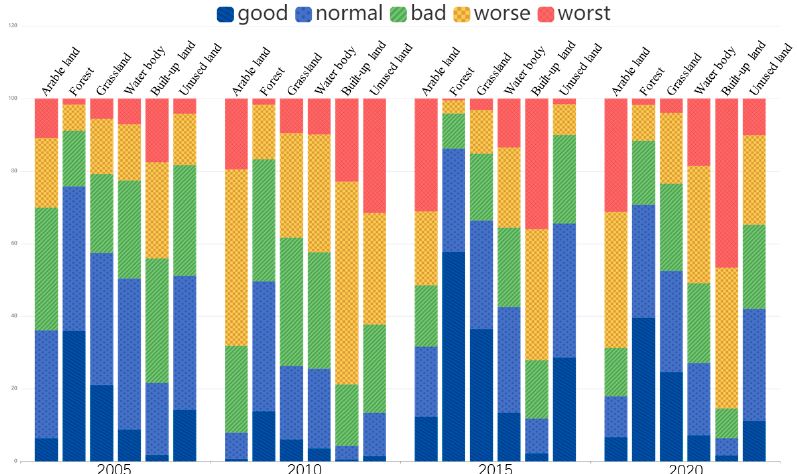
Figure 9. Proportion of UTCI of different LUCC types in BTH.